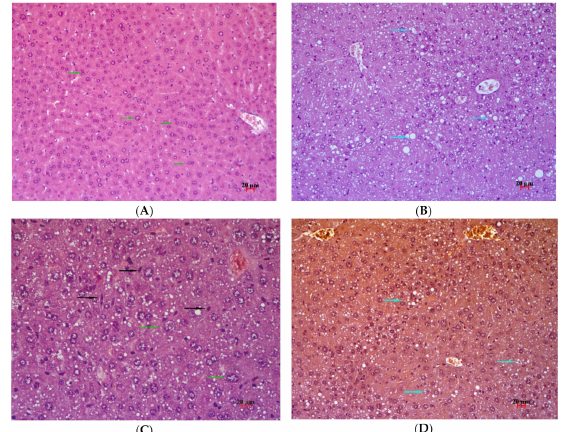
Figure 6. Histological examination of the liver of an untreated C57BL / 6 mouse ( A ) and an untreated AY mouse ( B – D ) at the end of the experiment. A. Nuclear polymorphism of hepatocytes. Staining with hematoxylin and eosin, magnification × 200. ( B ) Polymorphic lipid infiltration of hepatocytes. Staining with hematoxylin and eosin; magnification × 200. ( C ). Polymorphic lipid infiltration, nuclear polymorphism of hepatocytes. Staining with hematoxylin and eosin; magnification × 400. ( D ) Polymorphic lipid infiltration, no glycogen. Staining: periodic acid–Schi ff , hematoxylin, and orange G; magnification × 200. Light blue arrow: lipid infiltration, black arrow: Kup ff er cell, green arrow: nuclear